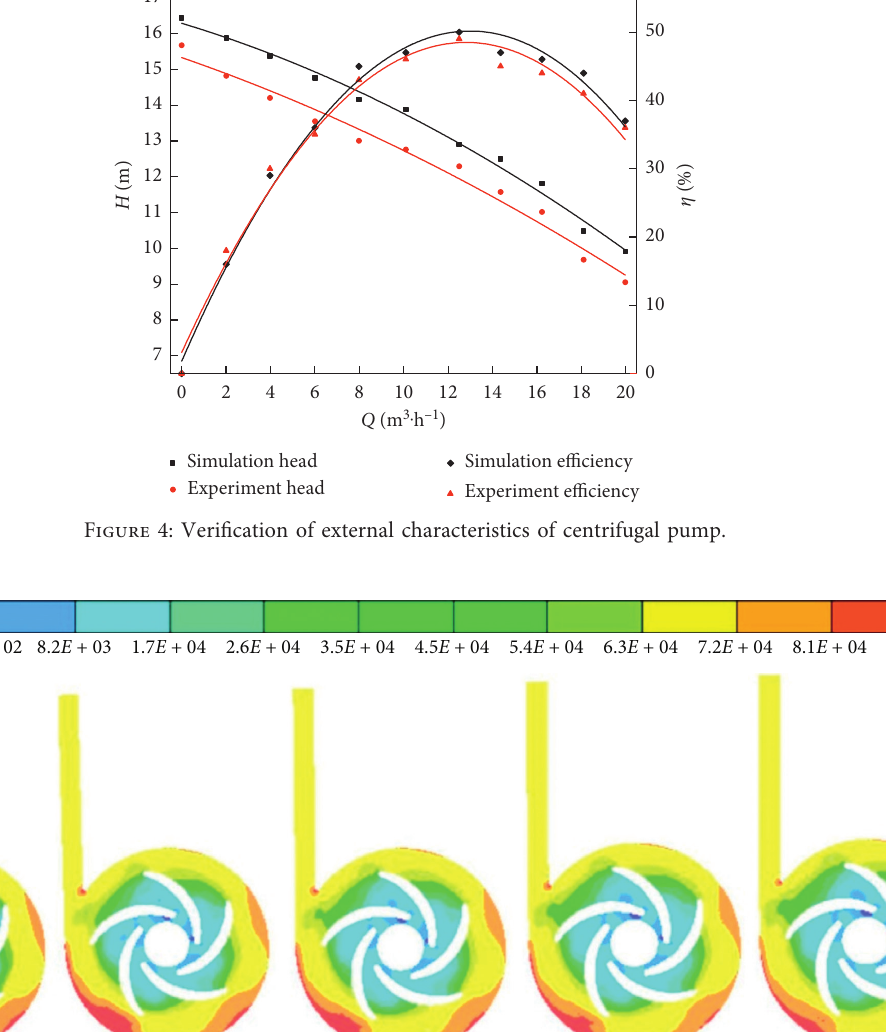
� 10%): (a) 0.01mm, (b) 0.05 mm, (c) 0.1mm, v